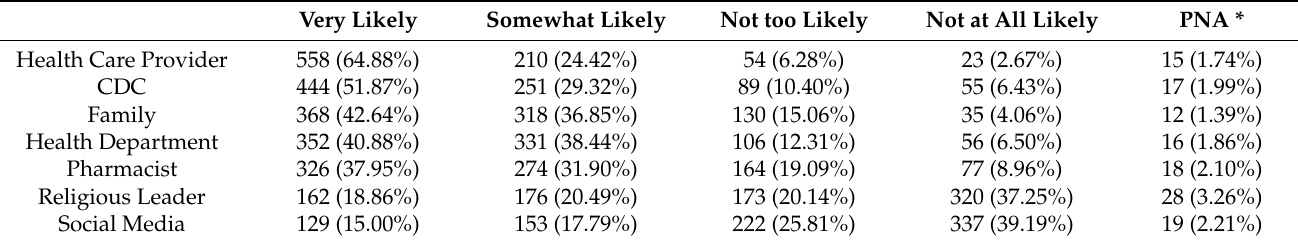
Table 2. Likelihood of turning to information sources when deciding whether to get a COVID-19 vaccine among hesitant adopters.